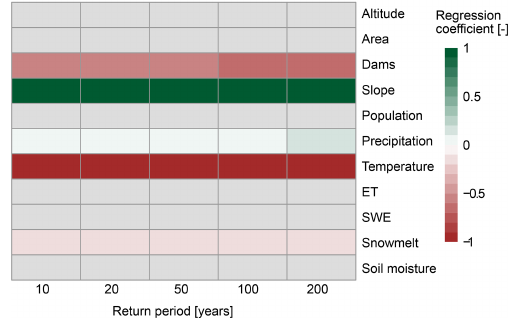
Figure 11. Predictor importance for flood quantiles. Regression co- efficients for significant explanatory variables retained when choos- ing the linear model with the lowest BIC ( α = 0 . 05). Green and red colours indicate positive and negative relationships between flood estimates and catchment characteristics, respectively. Grey colours indicate non-included (i.e. non-significant) explanatory